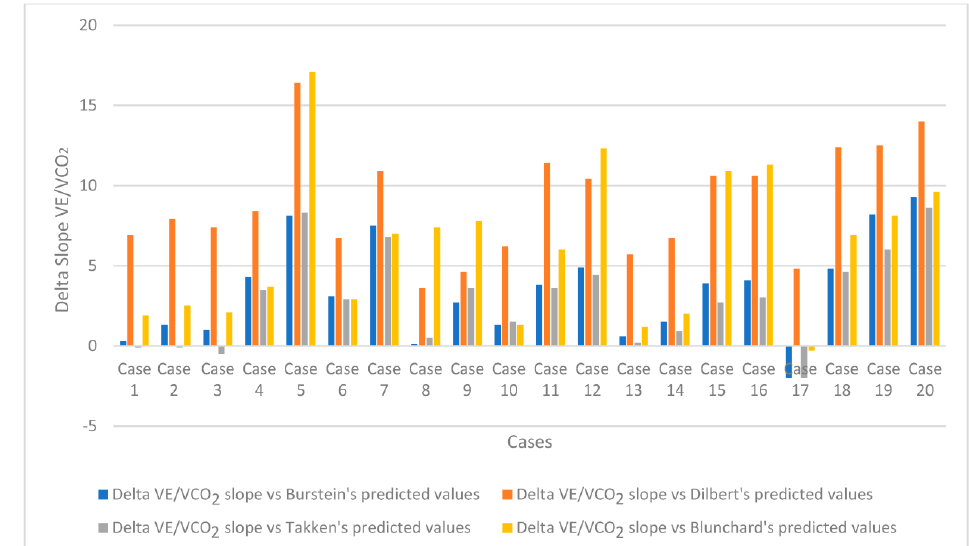
Figure 2. Delta VE/VCO 2 slope versus different predicted